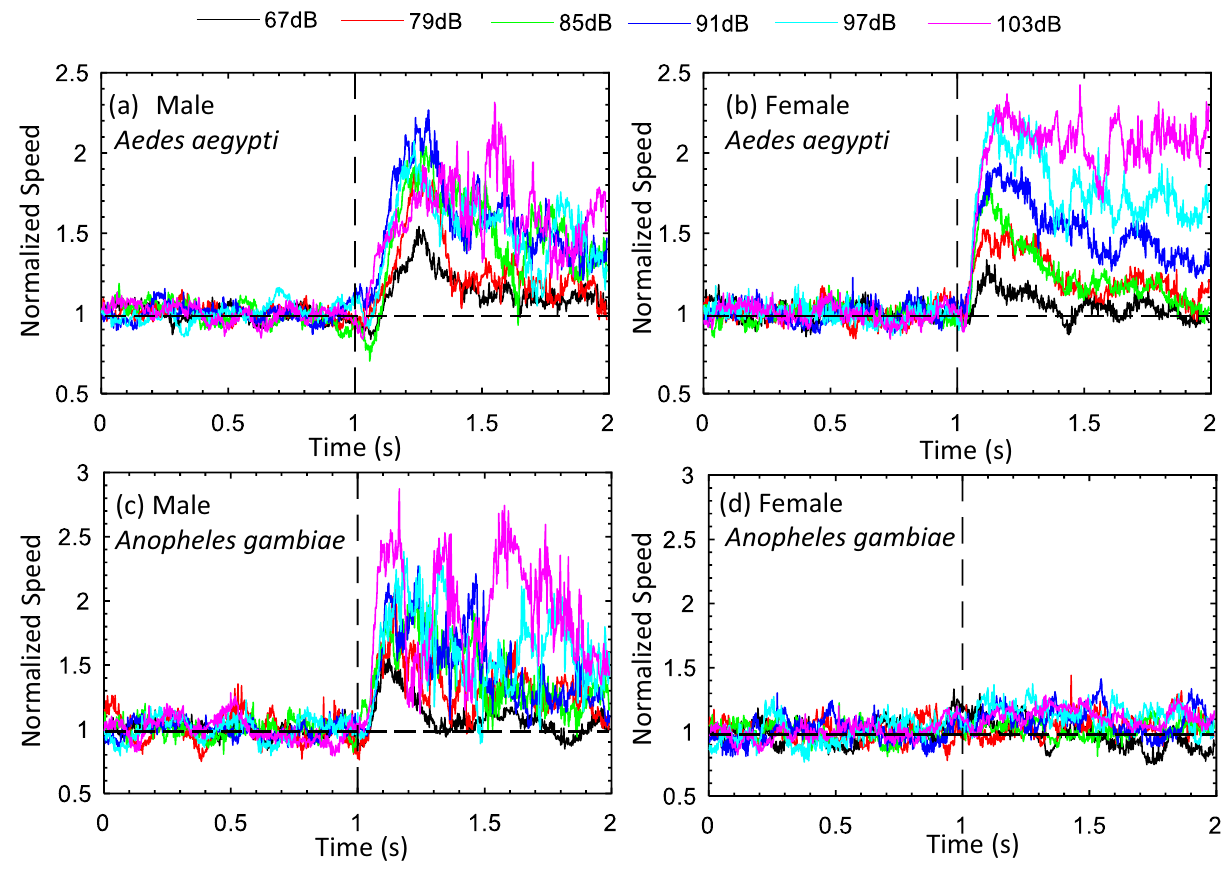
Figure 3. Effect of acoustic stimulus on the flight speed of mosquitoes at different intensities. The sound frequency was kept fixed at 400 Hz for all male mosquitoes and 200 Hz for the female mosquitoes. The flight speed results were normalized based on the average speed obtained from the 1st second in each test. ( a ), ( b ), ( c ), and ( d ) are normalized flight speeds of male Aedes , female Aedes , male Anopheles , and female Anopheles , respectively.